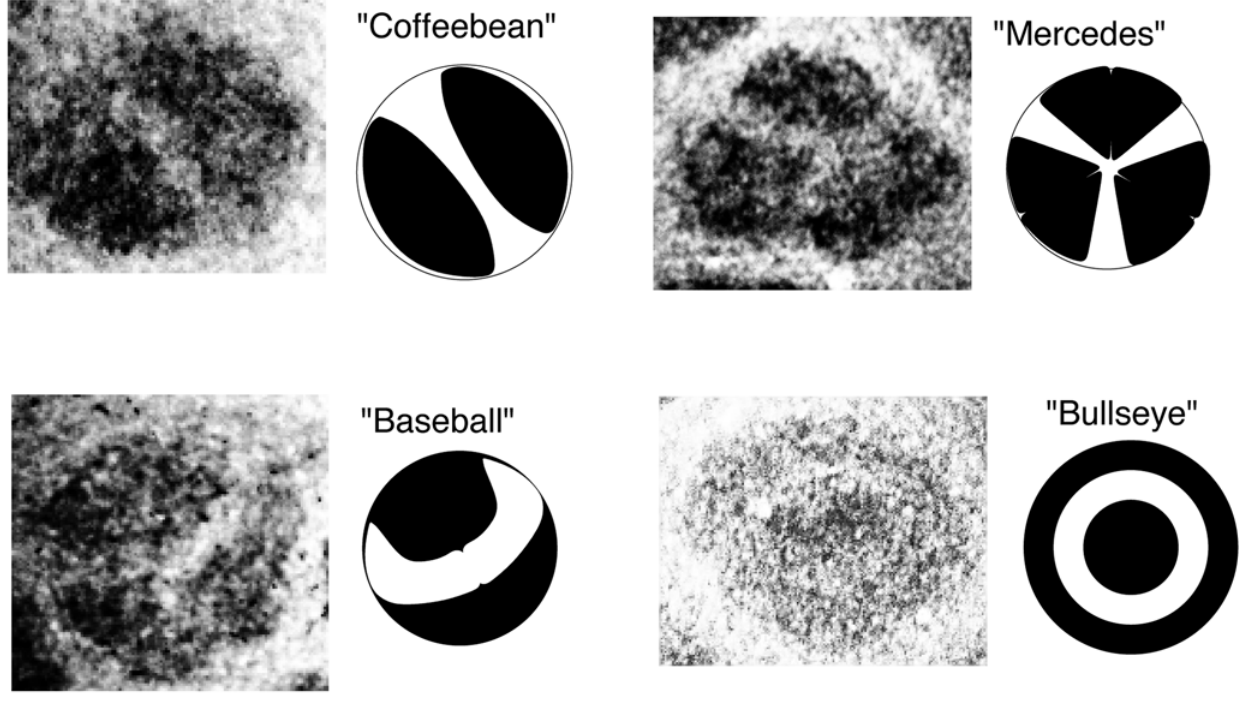
Figure 1. Examples of individual cytochrome oxidase stained barrels showing the four basic subbarrel patterns, illustrated schematically to the right of the corresponding photomicrograph. See also Fig. 4 [10]. Each sub-barrel is approximately 200 m m in diameter (see text and figure 3).